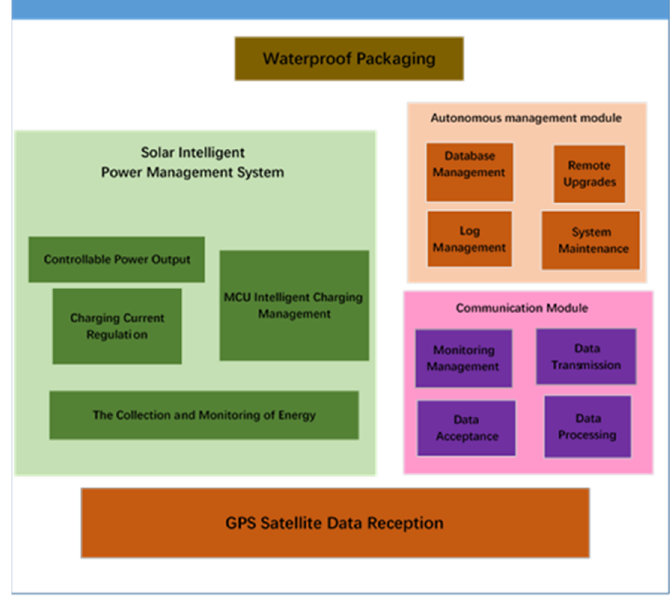
Figure 1. System